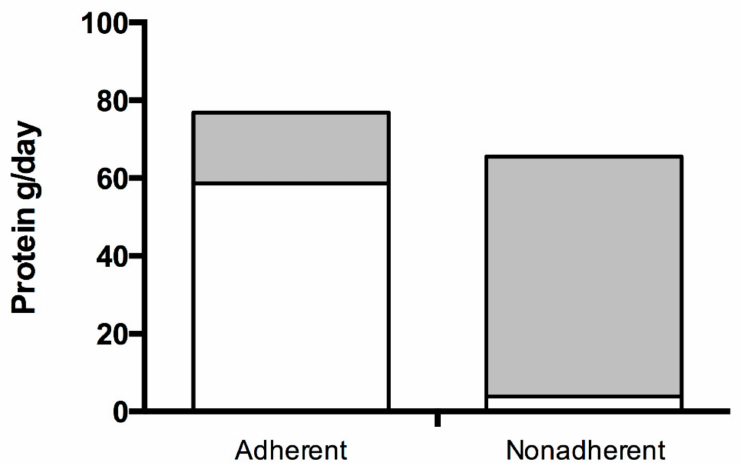
Figure 1. Contribution of low-phenylalanine protein substitutes (expressed as protein equivalents) and natural protein to total protein intake of adherent and nonadherent patients. White shaded bars [ ] represent protein equivalents from low-phenylalanine protein substitutes whereas grey shaded bars [ ] represent natural protein